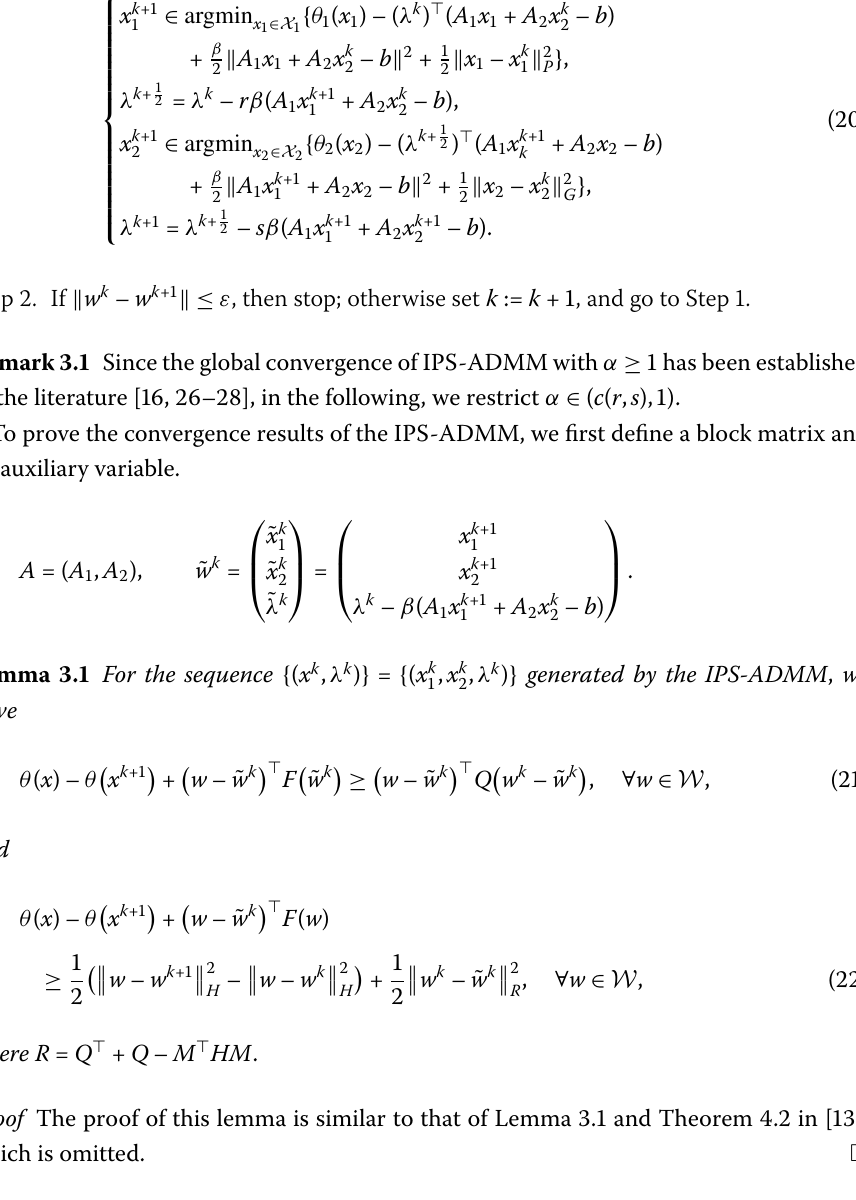
Algorithm . (The IPS-ADMM for problem